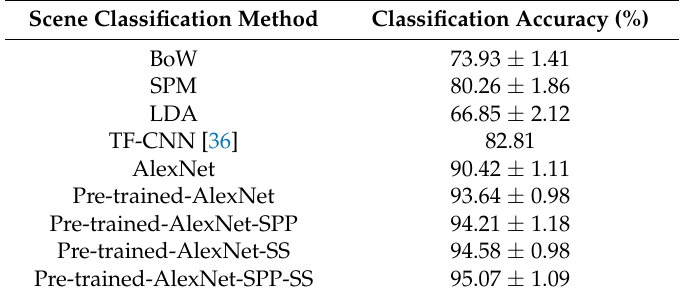
Table 2. Scene classification results for the Google image dataset of SIRI-WHU.